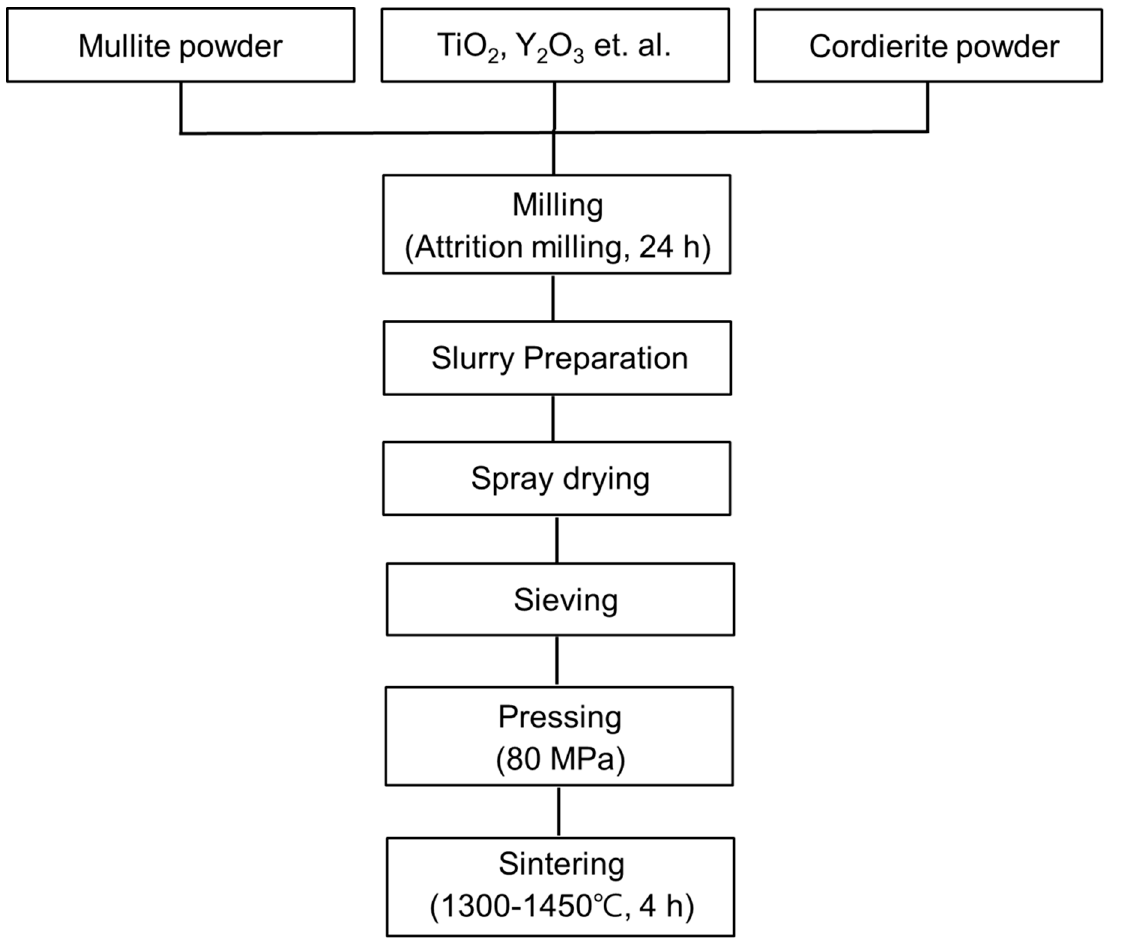
Figure 1. Flow diagram of the experimental procedure.